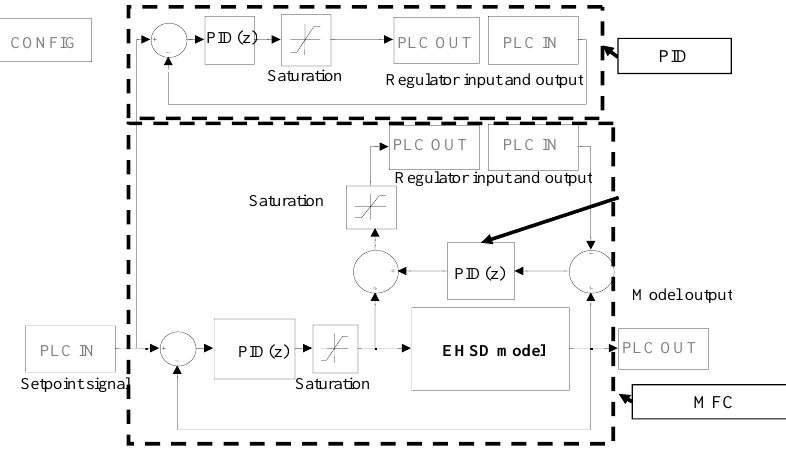
Figure 13. Control system implemented on PLC with used code generator.